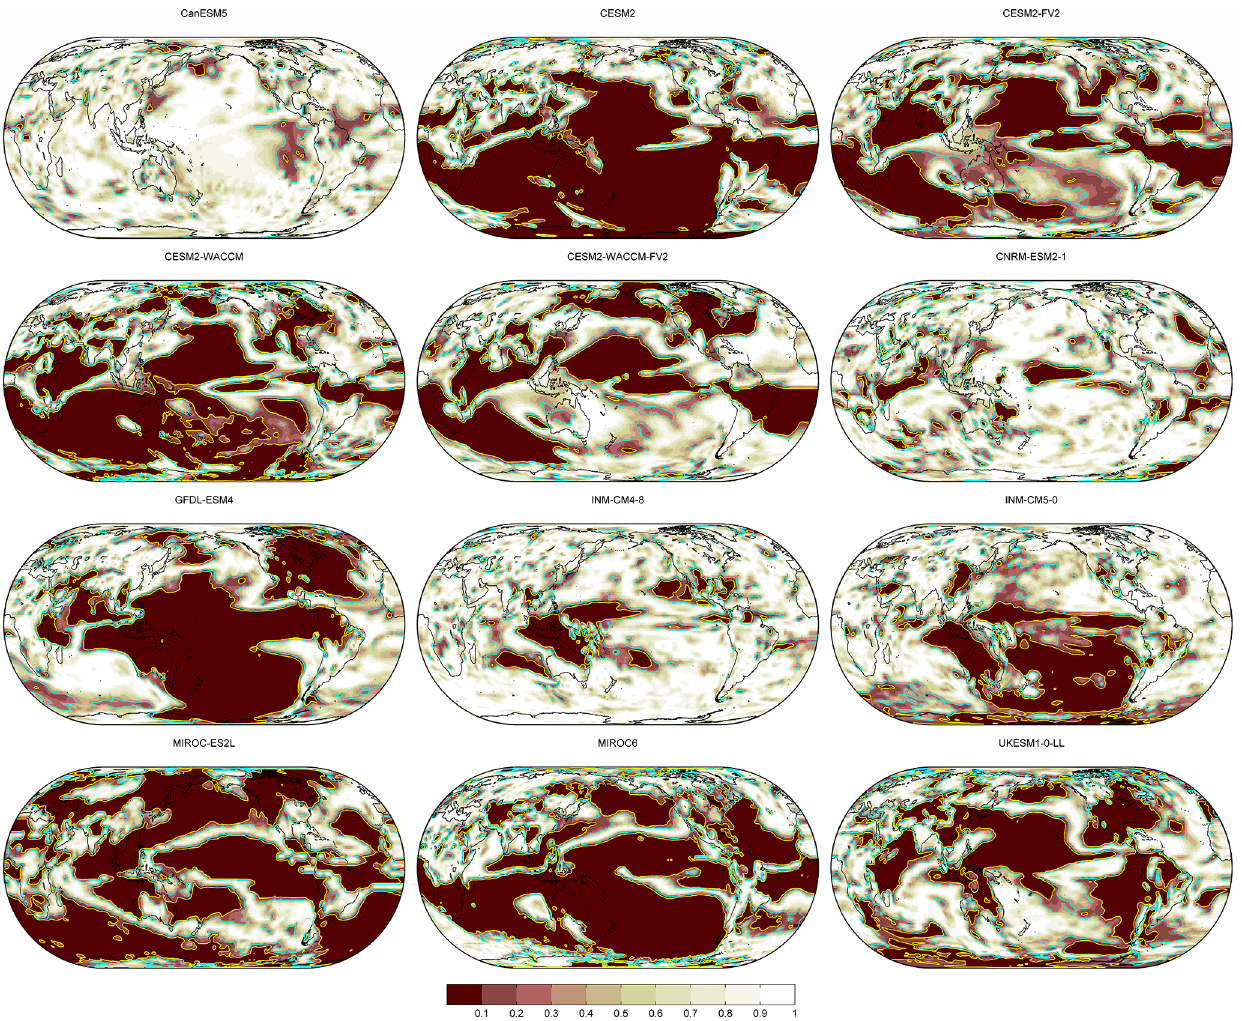
Figure 4. As in Fig. 1, except for the probability of the absence of Granger causality from ENSO and annual mean dry dust deposition over the period 1850–2014 for the historical simulation of 12 different models (see Tables S1 and S2). ENSO: El Niño–Southern